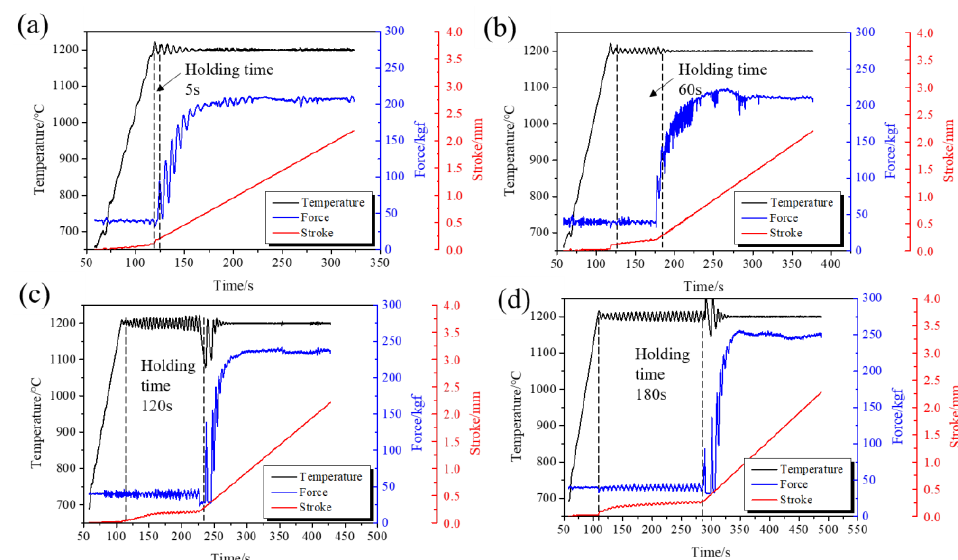
Figure 5. Extrusion force, temperature, and stroke displacement curves during the hot extrusion at different holding times. ( a ) 5 s; ( b ) 60 s; ( c ) 120 s; and ( d ) 180 s.